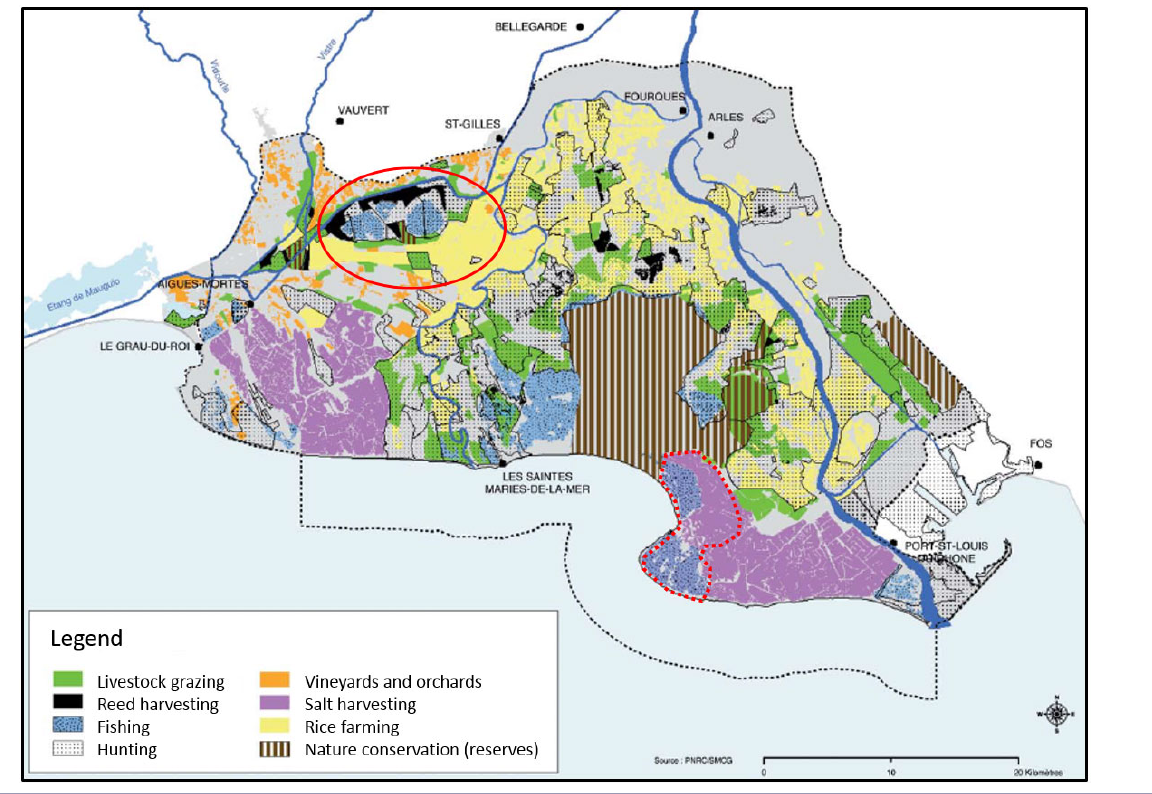
Fig. 1. Location of the Scamandre Marshes (red circle). Main land uses of the Camargue Biosphere Reserve, 2013. The new reserve created recently on abandoned salt pans is indicated by the red dotted line; other land uses such as other crops farming are in